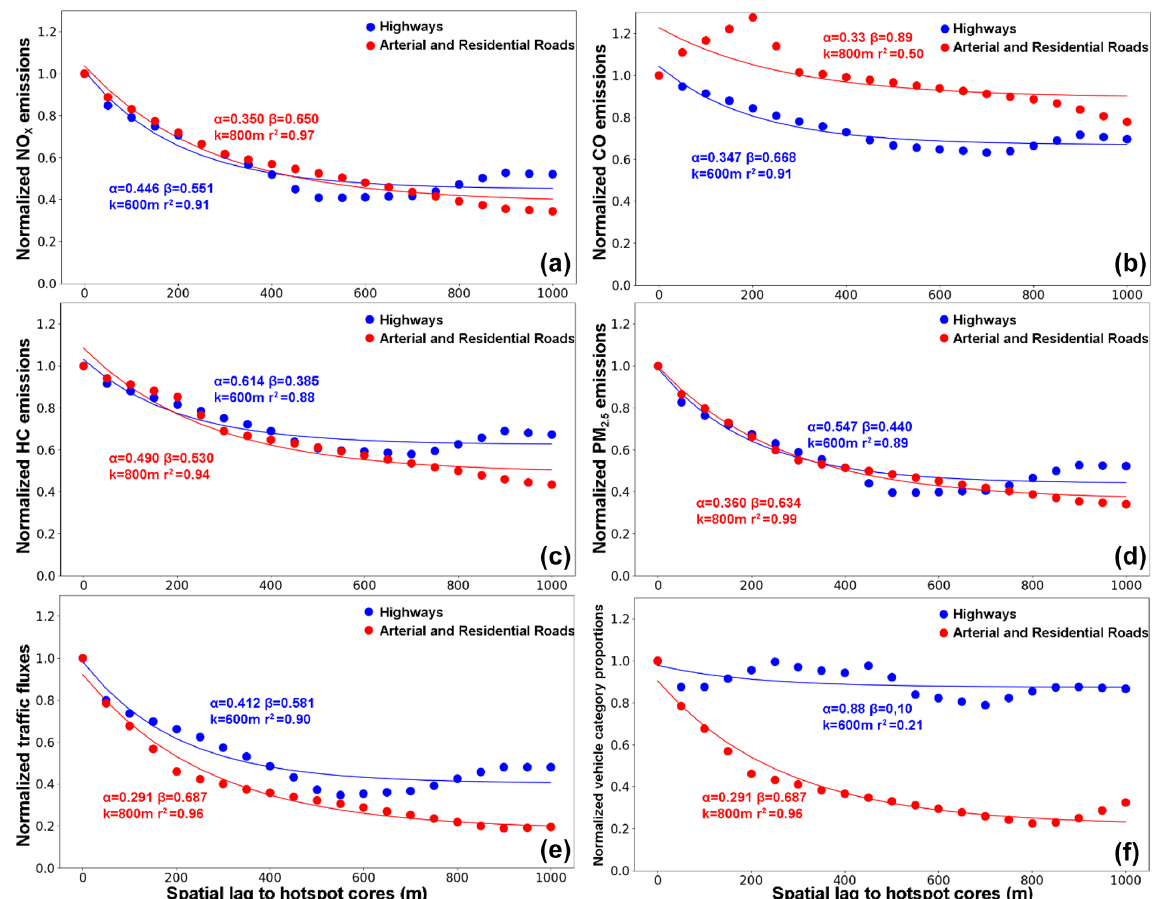
Figure 6. Decay of on-road vehicle emissions, traffic fluxes, and vehicle categories from indicative hotspots outwards on weekdays. (a– d) Points denote the ratio of hourly average emissions (NO x , CO, HC, and PM 2 . 5 ) over different road types at a given distance from hotspots to hourly average hotspot emissions. Error bars present standard deviations. An unconstrained three-parameter exponential model reproduces the decay relationships with high fidelity. The isotropic parameter d reflects the distance to the hotspot cores (m); the background parameter α represents the background emissions far from the hotspots ( d → 1000m); the parameter β represents the emission increment resulting from proximity to the hotspots; the decay parameter k governs the spatial scale over which emissions relaxed to α . The panels (e) and (f) are the same as (a) but for traffic fluxes and the vehicle category proportions,